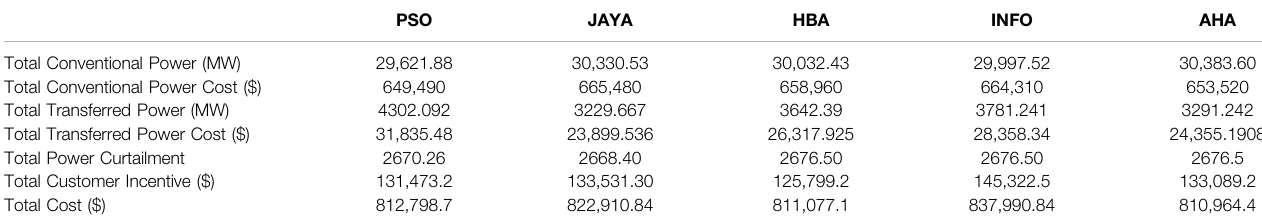
TABLE 11 | Cost breakdown for the studied optimization techniques (case study 2). PSO